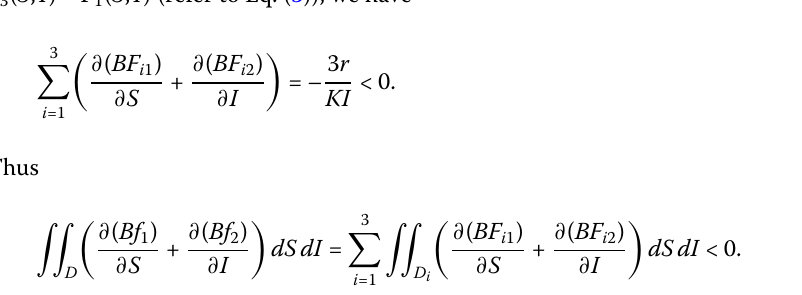
F 3 ( S , I ) = F 1 ( S , I ) (refer to Eq. (3)), we